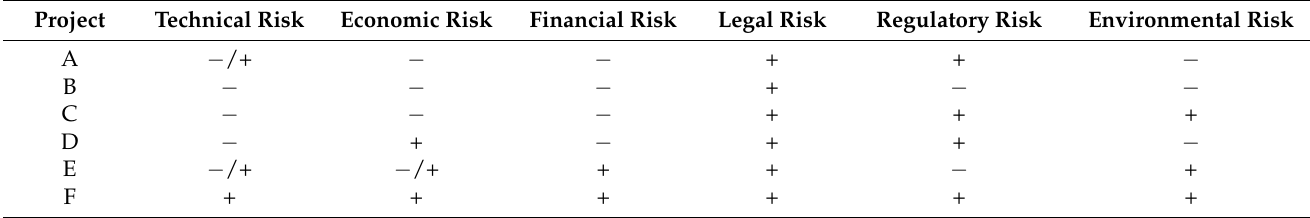
Table 9. Project risks of CHP investments in the planning